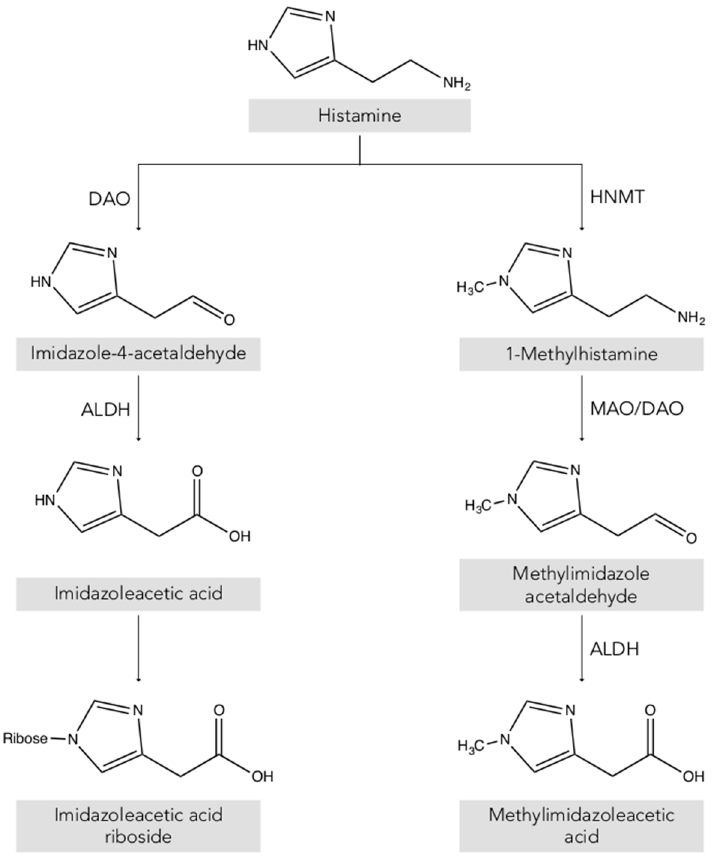
Figure 2. Histamine metabolism in humans. DAO: diamine oxidase; HNMT: histamine-N- methyltransferase; ALDH: aldehyde dehydrogenase; MAO: monoamine oxidase.